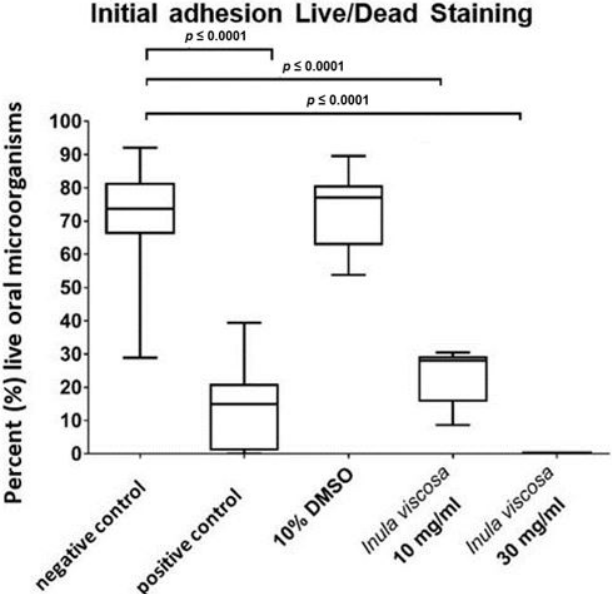
Figure 3. The boxplots represent the percentage of vital oral microorganisms that were evaluated by live/dead staining under the fluorescence microscope (FM). A negative control (NaCl 0.9%), a positive control (CHX 0.2%), a toxicity control (DMSO 10%), and the initial biofilm treated with I. viscosa extract at different concentrations (10 and 30 mg/mL) were evaluated. The line dividing the box shows the median. The p- values of the significantly different data are marked on the graphs.